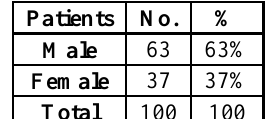
Table 1: Number and percentage of patients